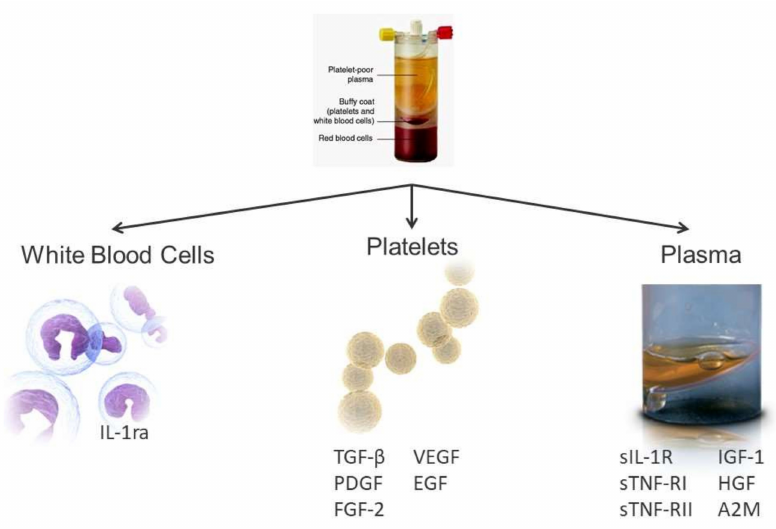
Figure 2. Cytokine contribution from components of blood used to make autologous therapies. PRP in vitro mechanistic data in OA have focused on the differences between LP-PRP and LR-PRP. The cytokines found in a LP-PRP and LR-PRP reflect their platelet and white blood cell concentration (Figure 1). LP-PRP has lower concentrations of platelet-derived growth factors (PDGF, TGF- β 1) than LR-PRP due to lower platelet concentrations (Table 1). LR-PRP has more white blood cell-derived cytokines over LP-PRP that include both pro- inflammatory cytokines (IL-1 β , MMP-9) [17] and anti-inflammatory cytokines (IL-1ra) [12]. IL-1ra is produced from monocytes [18] and neutrophils [19]. Therefore, in order for a PRP to have high concentrations of IL-1ra, WBCs need to be included. In order to ensure that the PRP is not pro-inflammatory, the ratio of IL-1 β and IL-1ra is important. In a common LR-PRP, the amount of IL-1 β is 3.5 ± 1.0 pg/mL while the IL-1ra is 22,395 ± 12,900